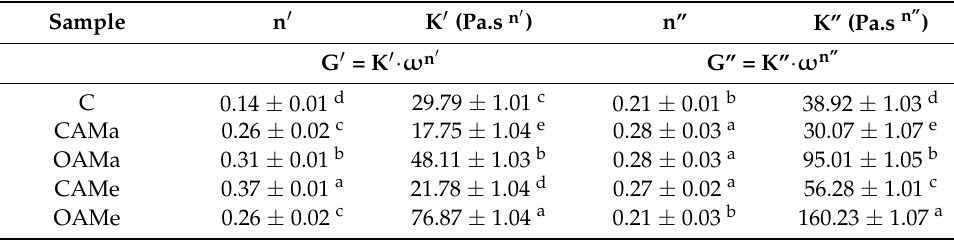
Table 4. Rheological properties of dough of gluten-free muffins produced with ACF.